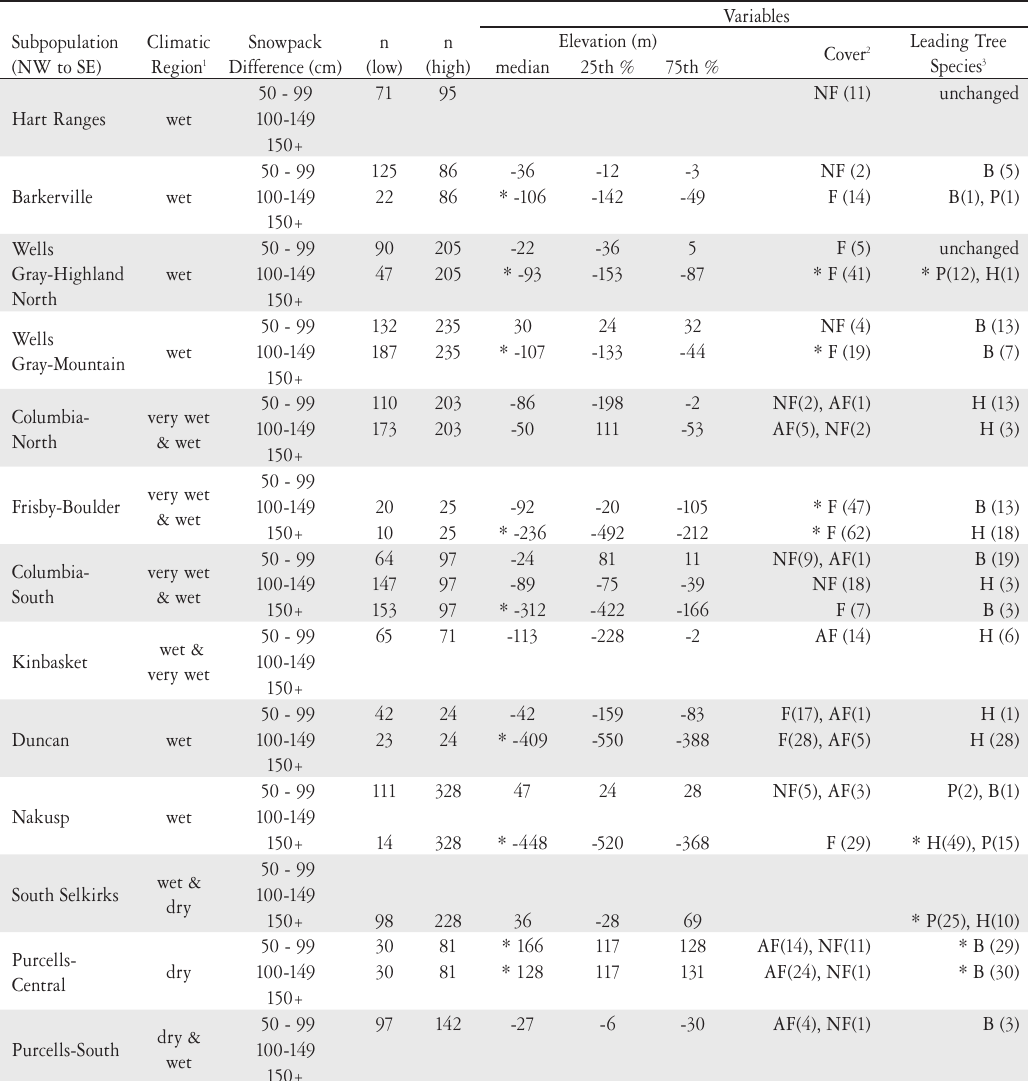
Table 2. Late-winter habitat use by mountain caribou in relatively low-snow years. Reported values are differences (elevation) or classes having increased use (cover and leading tree species; including absolute percentage increase) in low snow versus deep-snow years. Significance: * = P < 0.05/tests per subpopulation. Blanks indicate no or insufficient sample, or no habitat data